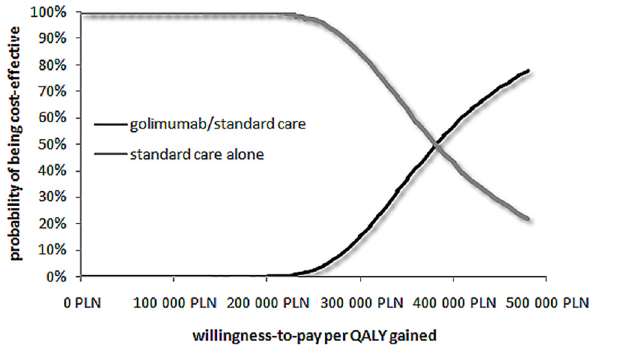
Fig 2. Cost-effectiveness acceptability curve showing the probability that golimumab with standard care is cost-effective versus standard care alone at a range of different threshold